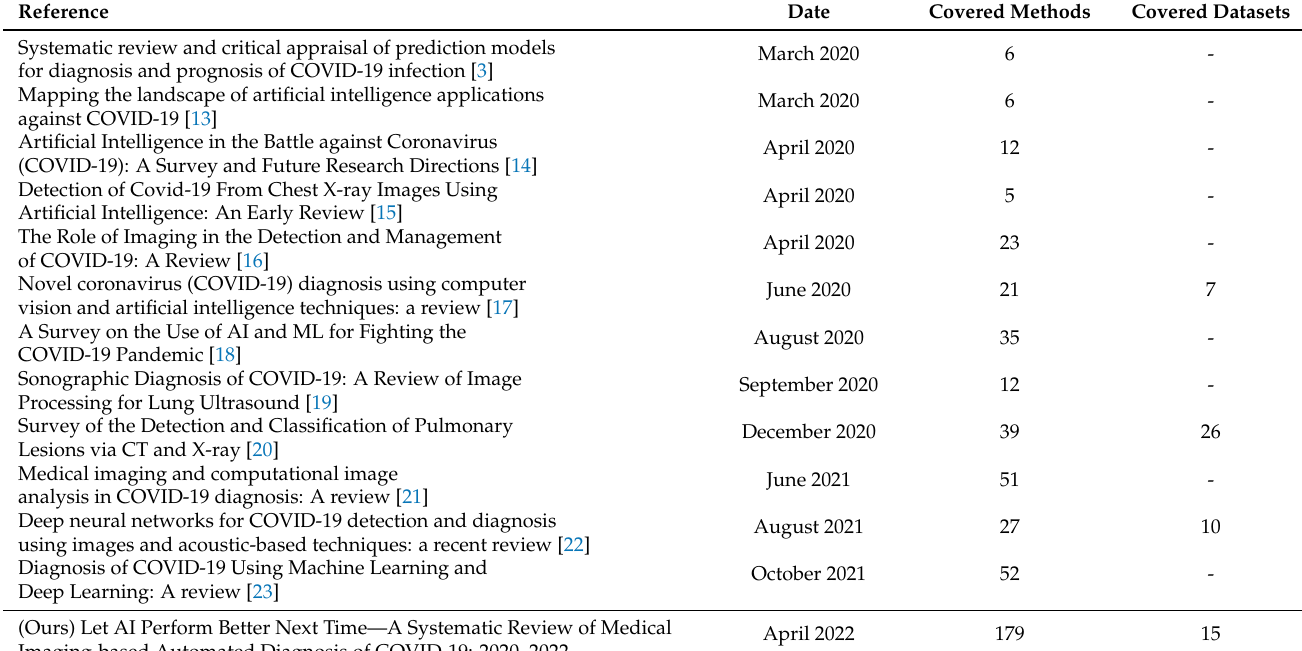
Table 2. Summarizing existing review or survey papers related to automated diagnosis of